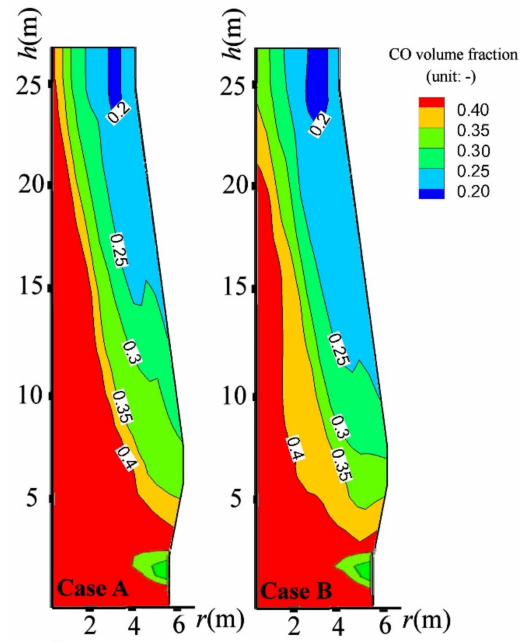
Figure 9. Profiles of CO volume fraction in cases A and